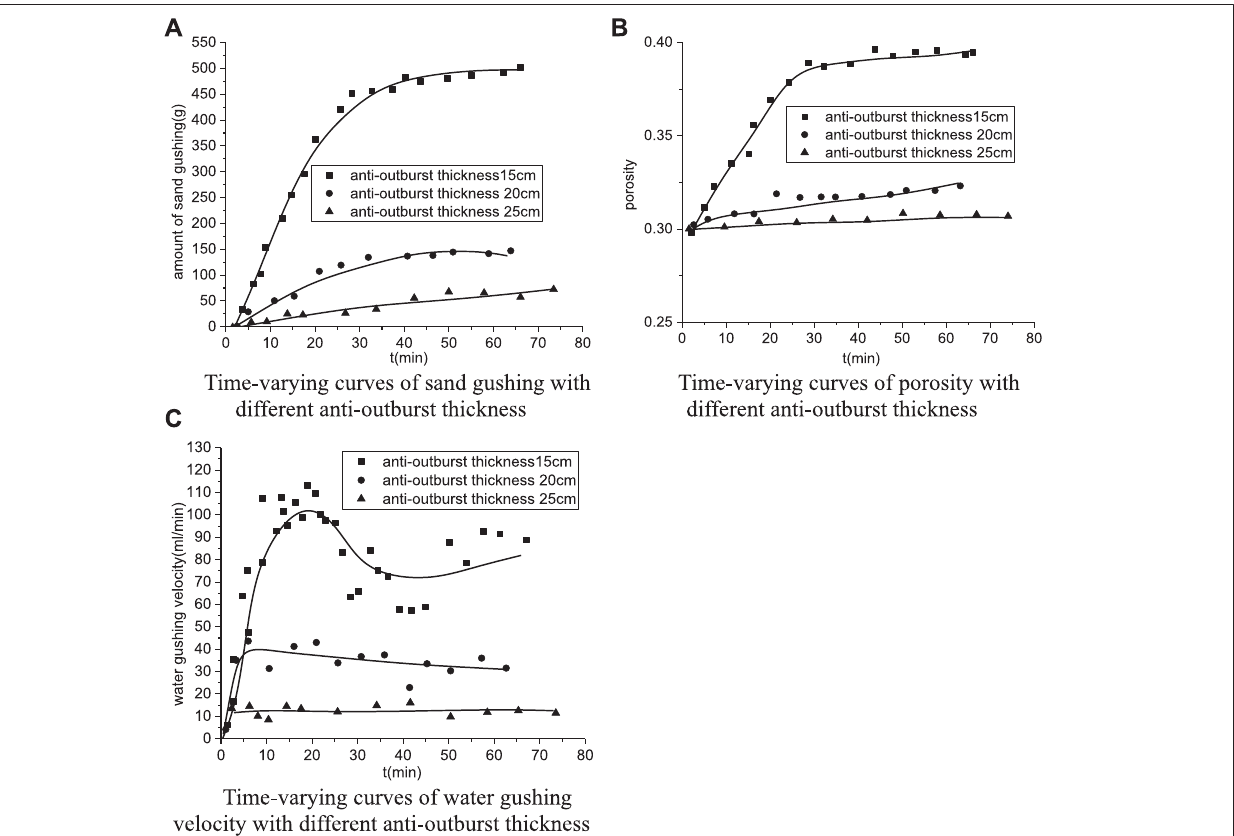
FIGURE 13 | In fl uence of con fi ning pressure on the evolution of water bursting and sand gushing: (A) time-varying curves of sand gushing with different anti- outburstthicknesses, (B) time-varyingcurvesofporositywithdifferentanti-outburstthicknesses,and (C) time-varyingcurvesofwatergushingvelocitywithdifferentanti- outburst